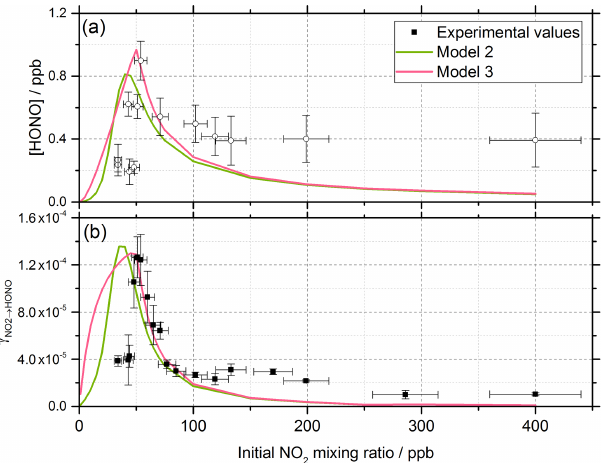
Figure 10. Experimental values (open circles with 1 σ error bars), Model 2 (green line) and Model 3 (pink line) calculations for (a) HONO concentration after 52s illumination and (b) NO 2 re- active uptake coefficient, γ NO , as a function of the ini- 2 → HONO tial NO 2 mixing ratio. The mechanisms used for these model runs included a 2 : 1 stoichiometric relationship between the NO 2 ad- sorbed on the TiO 2 aerosol surface and the HONO produced, as well as additional HONO loss reactions which are dependent on NO 2 ; see Table 1 for details. Model 2 and Model 3 use an Eley– Rideal and Langmuir–Hinshelwood mechanism, respectively, for the formation of the NO 2 dimer on the aerosol surface. Modelled γ NO was calculated using Eqs. (6) and (7) with a constant 2 → HONO surface area of 1.6 × 10 − 2 m 2 m − 3 chosen to match the aerosol sur- face area density of (1.6 ± 0.8) × 10 − 2 m 2 m − 3 shown in the exper- imental [HONO] values in panel (a)